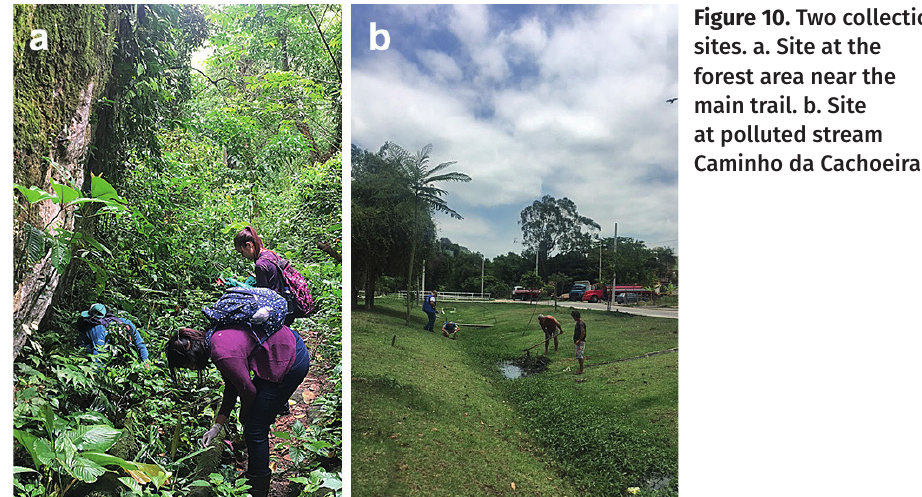
Figure 10. Two collection sites. a. Site at the forest area near the main trail. b.